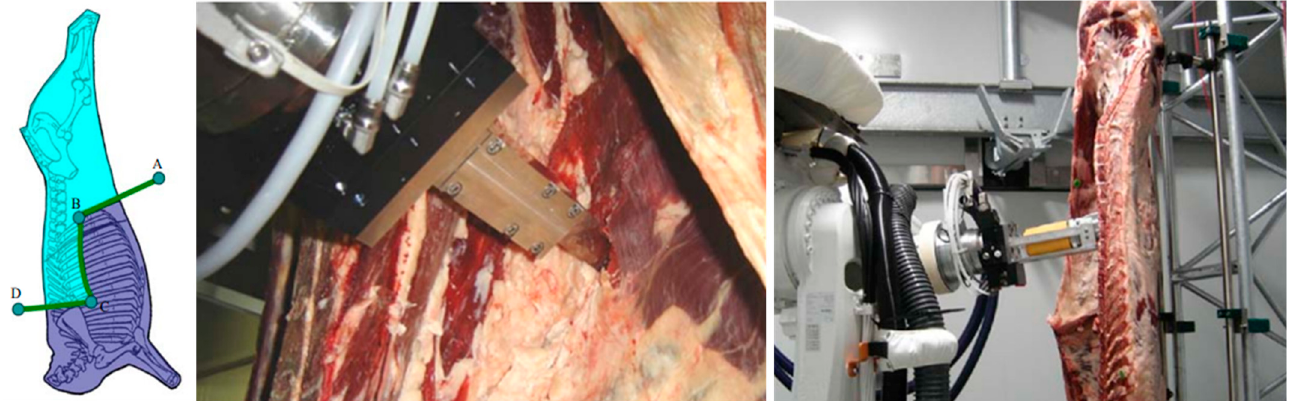
Figure 4. Beef carcass industrial processing using robots. The Z-cutting and prototype cutting system [51] (From Guire et al. Robotic cell for beef carcass primal cutting and pork ham boning in the meat industry. Reprinted with permission of Emerald Publishing Limited, Bingley, Copyright © 2010).